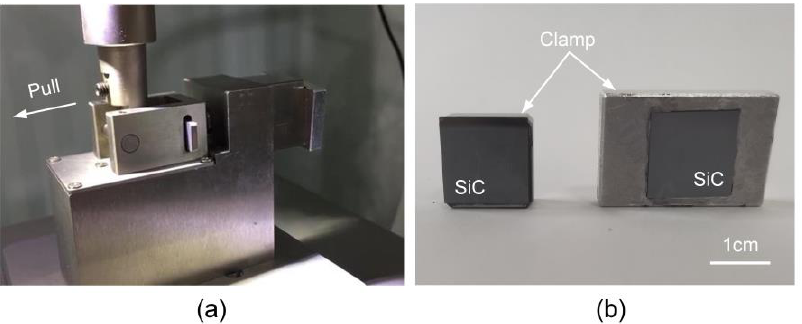
Figure 8. Bonding strength testing of SiC cavity structure: ( a ) tensile testing machine; ( b ) fracture of the bonding structure. the bonding